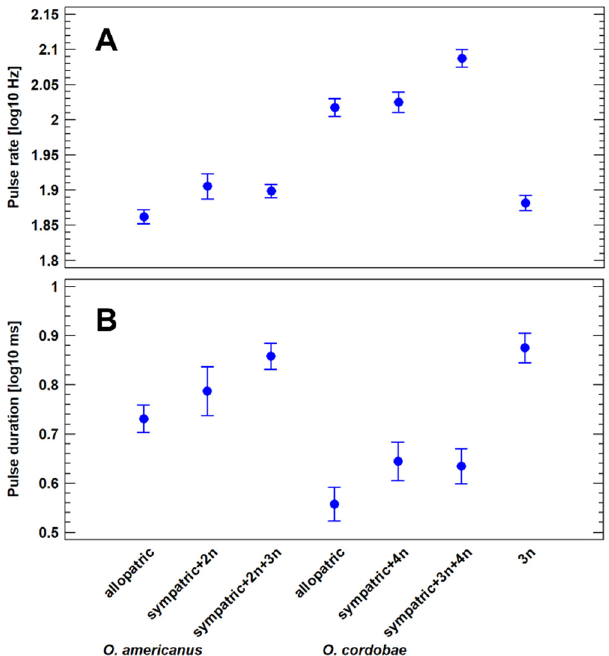
Figure 5. Sensitivity to the presence of one or two syntopic Odontophrynus taxa in temperature-adjusted call parameters pulse rate ( A ) and pulse duration ( B ). Each dot represents the least square mean and its corresponding 95% Bonferroni confidence interval, calculated using an ANCOVA on the log10-normalized response variables.